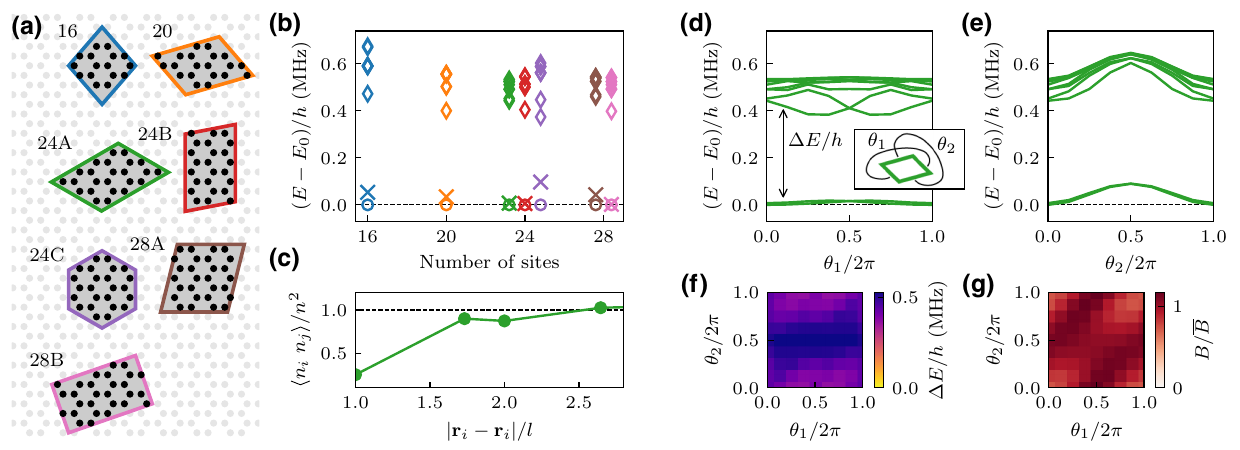
FIG. 2. The ground state on a torus. (a) For quarter filling, the ten lowest eigenstates are calculated via exact diagonalization for different clusters of the honeycomb lattice with periodic boundary conditions. (b) For all clusters, the lowest eigenstate (circle) and the second-lowest eigenstate (cross) give rise to a nearly twofold-degenerate ground state, separated from higher excited states (diamonds) by a gap (cid:3) E / h (cid:2) 0.2 MHz. E 0 is the respective energy of the lowest eigenstate. (c) For the ground state, density-density correlations + n b and average density n is short ranged and is show no order: the correlation function (cid:7) n i n j (cid:2) / n 2 with density operator n i = n a i i depicted exemplarily for the clusters 24A . (d),(e) We now apply twisted boundary conditions with twist angles θ 1 and θ 2 , as illustrated in the inset. We plot the lowest eigenenergies as a function of one twist angle while keeping the other zero for the clusters 24A . The ground state remains quasidegenerate. (f) The gap to the first excited state stays wide open, independent of the twist angles. (g) The normalized Berry curvature B / B of the quasidegenerate ground state is mostly homogeneous as a function of the twist angles. Here,